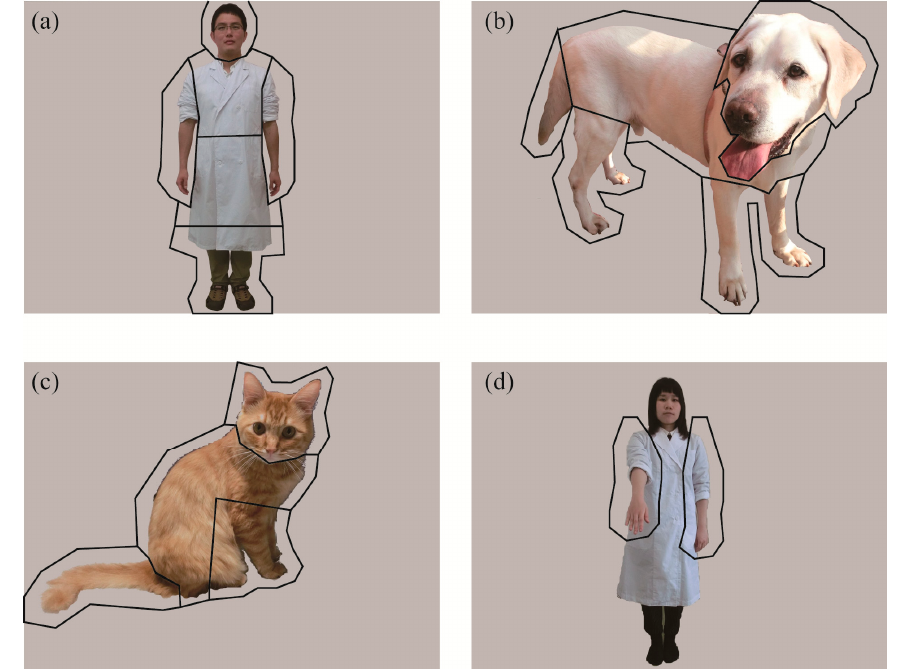
Figure 2. Examples of stimuli used in the experiment and areas of interest (AOI) employed in the analyses: (a) human without a hand-sign, (b) dog, (c) cat, and (d) human with a hand-sign. The frames drawn on the pictures (a), (b), and (c) indicate the AOI utilized in the analysis comparing the three species and on the picture (d) indicates the AOI utilized in the analysis comparing stimuli with and without a hand-sign.